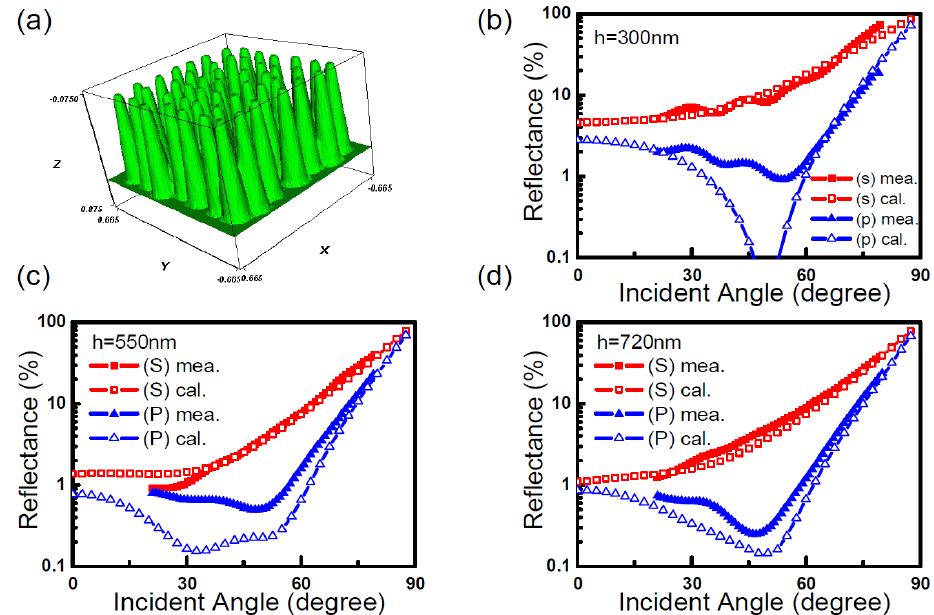
Figure 23. ( a ) Geometry for disordered GaN cones modeled as a 49-cone unit cell using RCWA. Measured and calculated reflectance for the disordered nanopillars shown in Figure 23 at s (TE) and p (TM) polarizations show that RCWA is more accurate in TE mode than in TM mode for pillars of ( b ) 300 nm; ( c ) 550 nm; and ( d ) 720 nm. Reprinted with permission from reference [114], Copyright 2008 Optical Society of